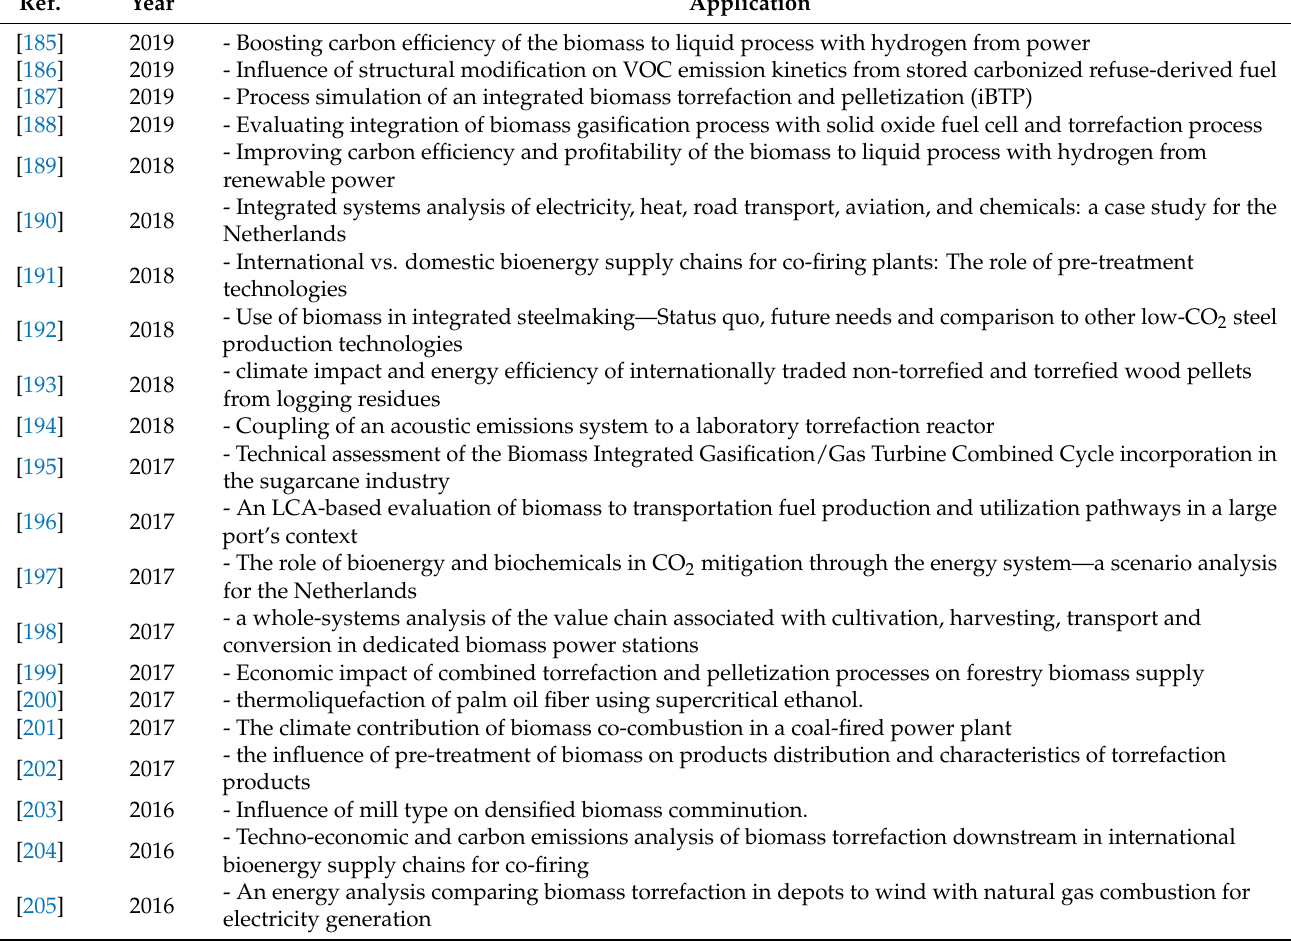
Table A5. Other issues regarding the use of torrefied biomass—detailed thematic analysis.